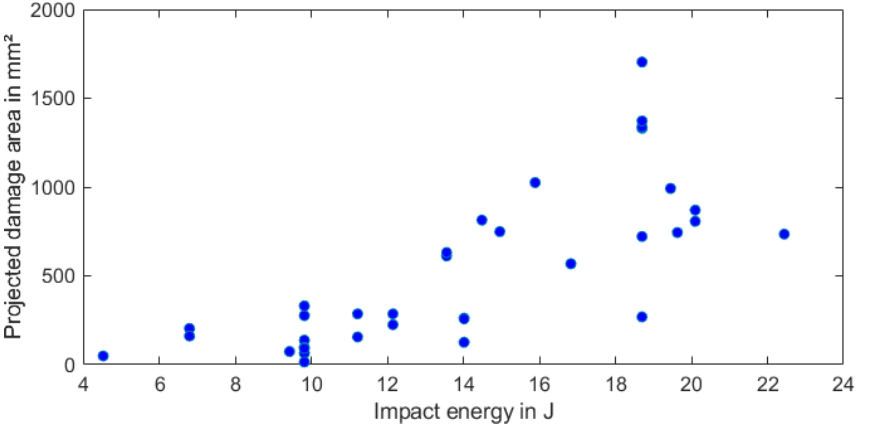
Figure 3. Damage areas as a function of impact